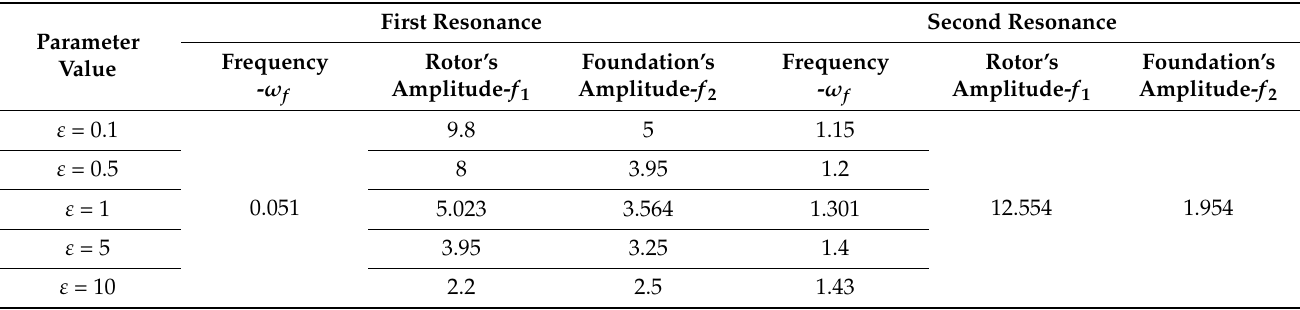
Table 3. Amplitudes and resonant frequencies for different degrees of